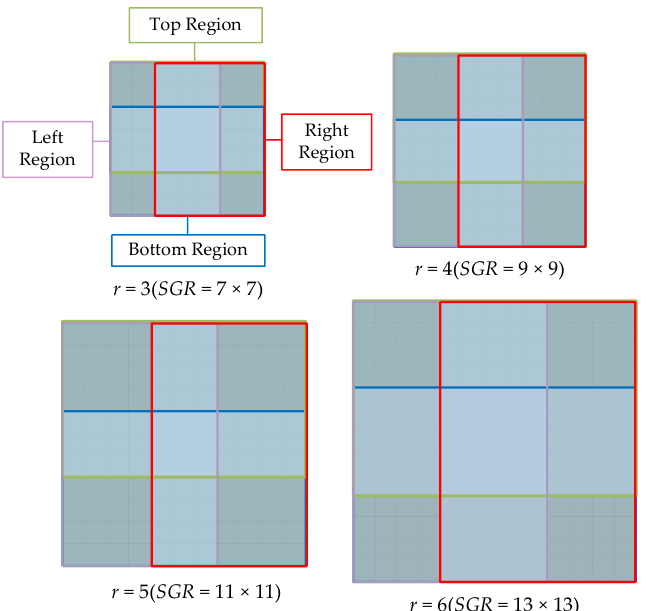
Figure 5. Four kinds of feature extraction windows with different r values.